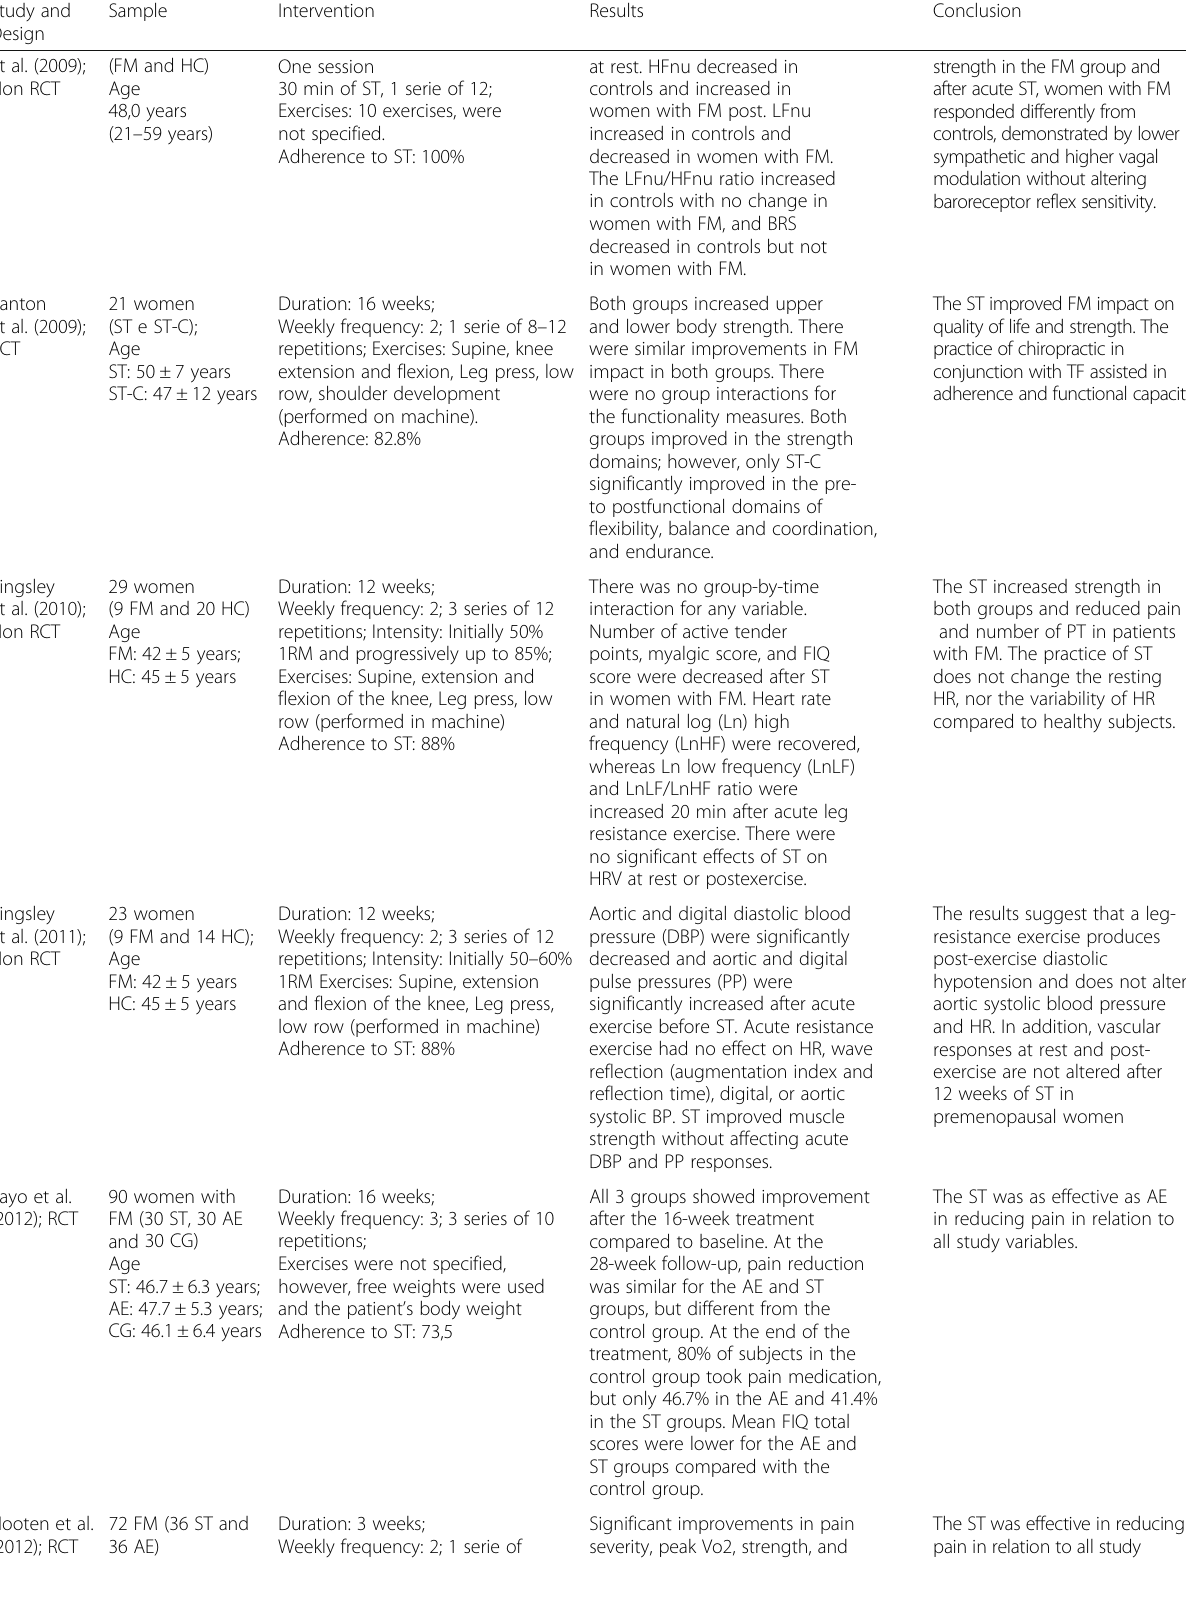
Table 2 Characteristics and results of experimental studies with strength training for patients with fibromyalgia syndrome (Continued) Study and